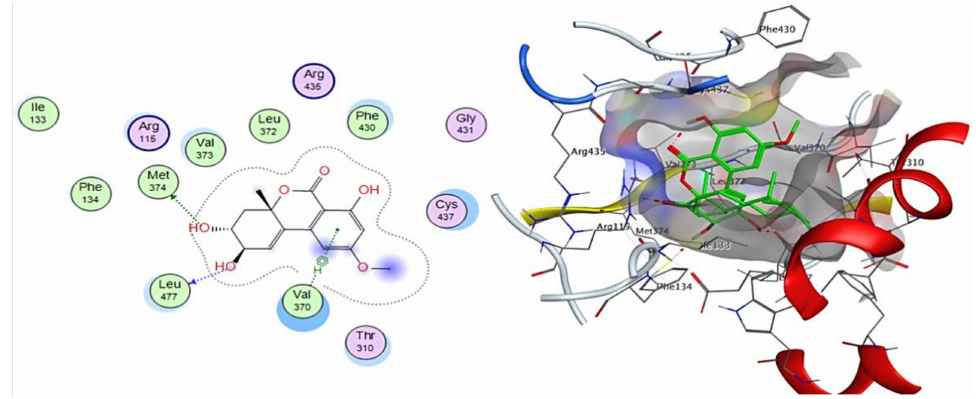
Figure 9. The 2D and 3D interactions of 4’-epialtenuene with human aromatase cytochrome P450 active site.